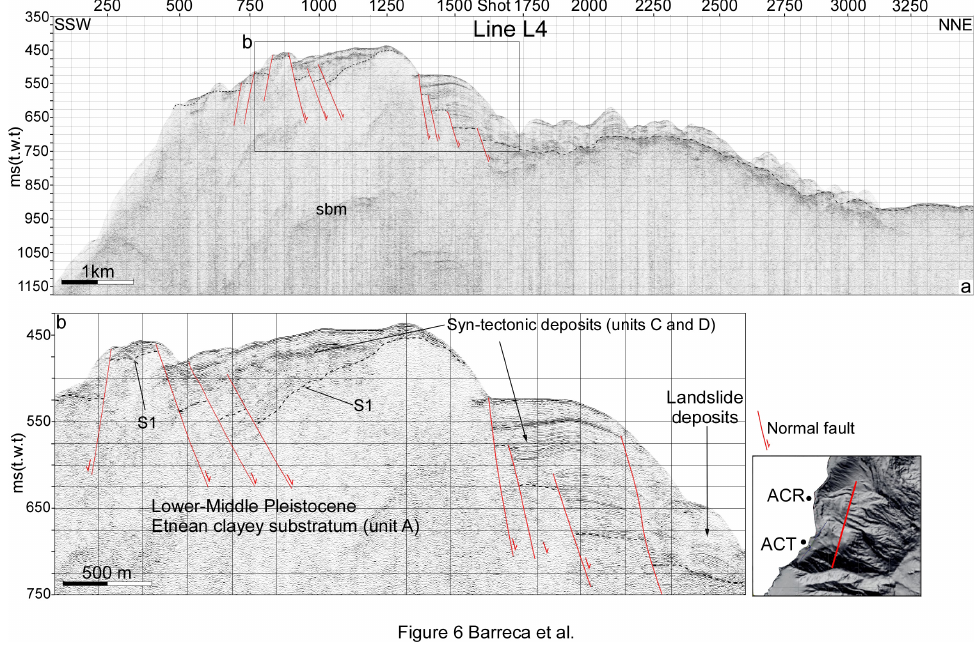
Figure 6. ( a ) Interpreted NNE-SSW trending L4 line showing the offshore prolongation of the NW-SE-trending, mainly NNE-dipping normal faults, also recognized on line L3 (see Figure 1b for location). Faults displaced Middle Pleistocene to Holocene deposits also affecting the seafloor; ( b ) Box b displays part of the line at smaller scale. ACR: Acireale; ACT: Aci Trezza; S1: erosional surface; sbm: sea bottom